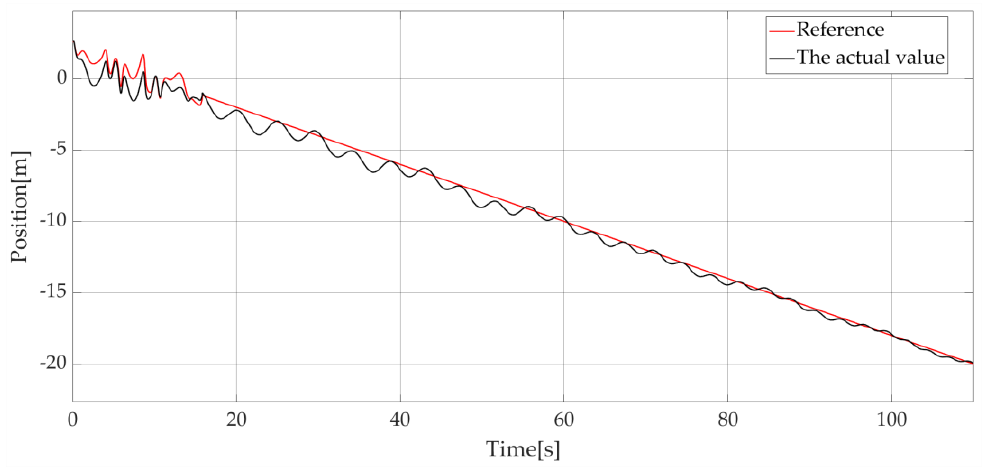
Figure 20. L = 27 m, V = − 0.2 m/s, Position of the load without compensation.